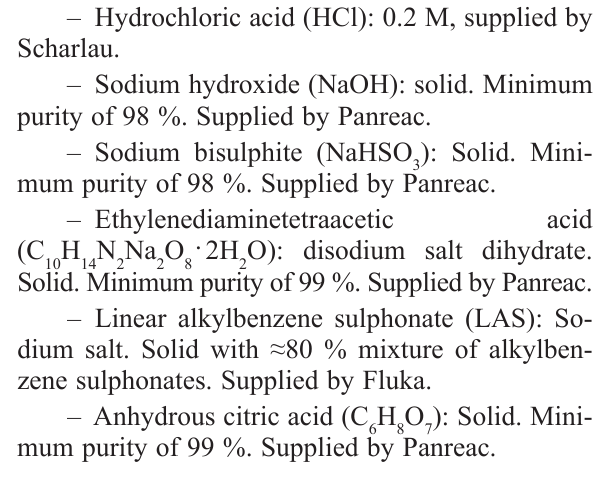
Fig. 1 Spiral-wound desalination plant